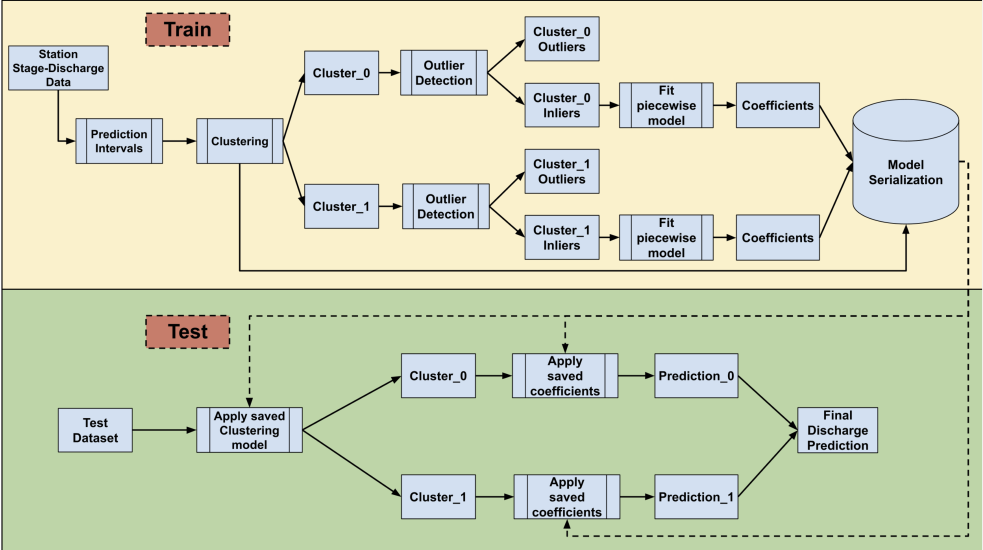
Figure 4. Data-driven Rating Curve high-level workflow. The workflow included filtering the records to a 95% prediction interval, then dividing the data into separate clusters to account for changes in the flood plain before running the outlier detection algorithm in these groups. Finally, a piecewise linear regression was run through the inliner